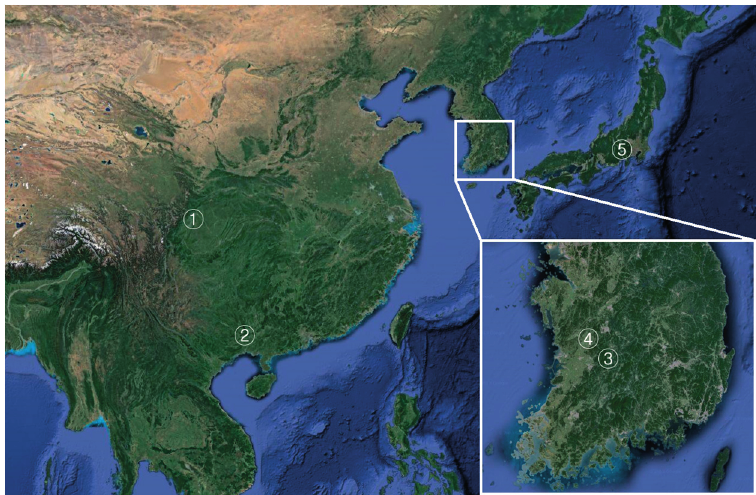
Figure 4. Collecting sites on each regional population of D. hopei (1, Shichuan China; 2, Guangxi China; 3, Wanju Korea; 4, Nonsan Korea; 5, Nirasaki-shi